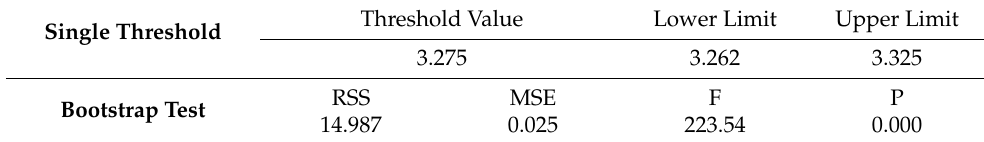
Table 7. Energy consumption structure threshold.